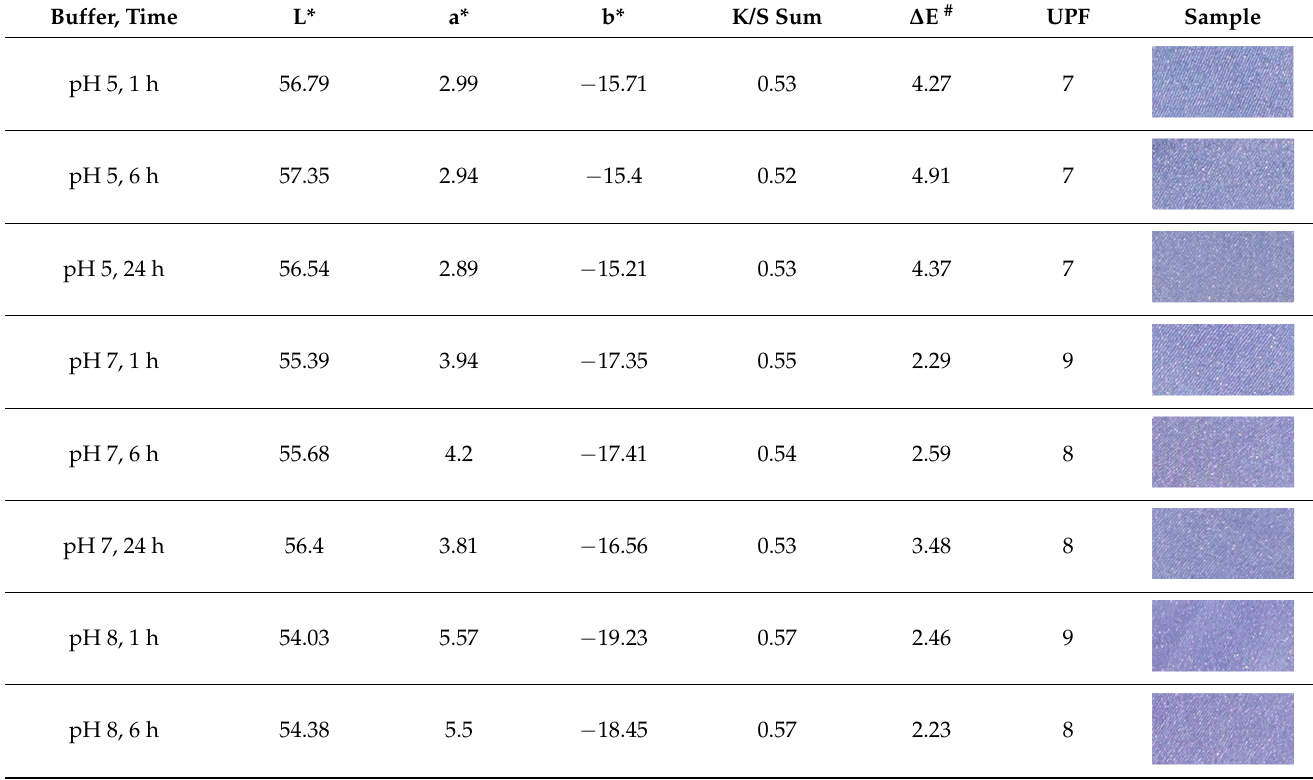
Figure 7. K/S of the silk samples after immersion in a Britton–Robinson solution at ( a ) pH 5, ( b ) pH 7, ( c ) pH 8, ( d ) pH 9, and ( e ) pH 10 for 1, 6, and 24 h (final samples of the stability test). Table 8. Color coordinates (L*-lightness, a*-yellowness/blueness, and b*-redness/greenness), K/S, ∆ E, and UPF of the samples functionalized with AzoIz.Pip and immersed in buffer solutions to assess the stability and leaching of the dye.